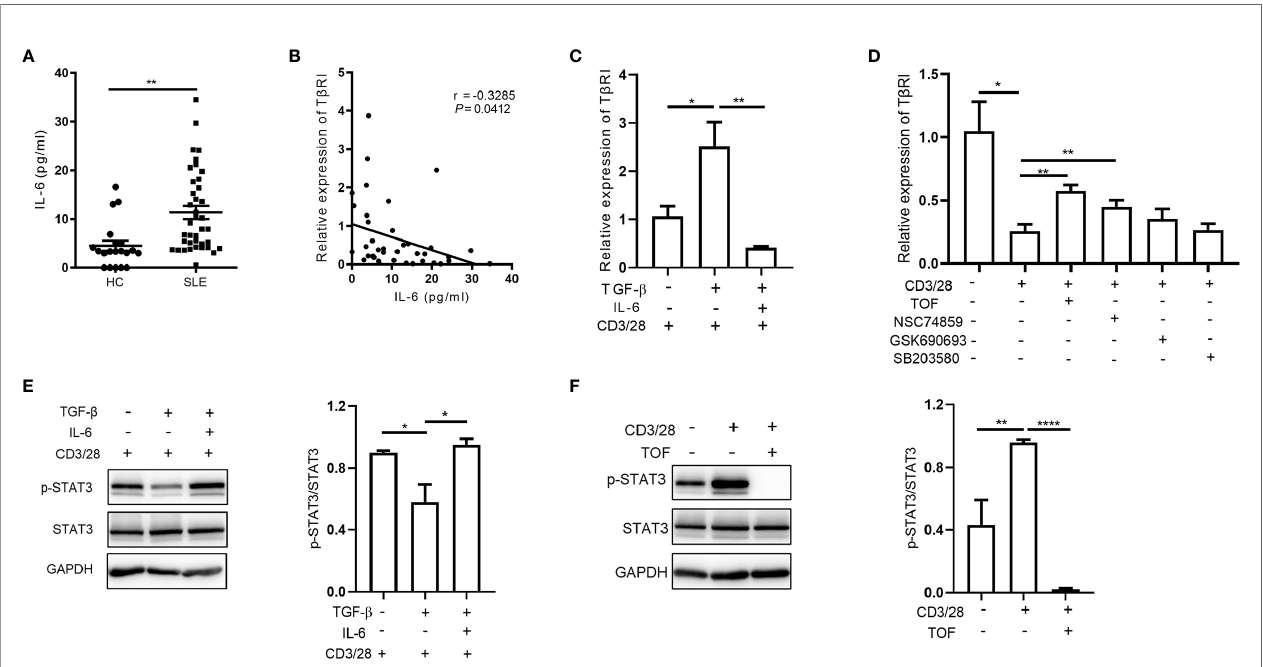
FIGURE 2 | IL-6 downregulates TGF b RI expression via JAK/STAT3 pathway. (A) Plasma IL-6 levels in SLE patients (n = 39) and HC (n = 20) were measured. (B) Correlation between IL-6 and TGF b RI (T b RI) mRNA level was evaluated (n = 39). (C) The TGF b RI mRNA level in naïve CD4 + T cells from SLE PBMCs was assessed after stimulation with anti-CD3/CD28 beads and TGF- b (5 ng/ml) in the absence or presence of IL-6 (100 ng/ml) for 24 h (n = 4). (D) The level of TGF b RI mRNA (n = 3) in anti-CD3/CD28-treated naïve CD4 + T cells from SLE PBMCs was assessed after treatment with JAK inhibitor (tofacitinib, TOF), STAT3 inhibitor (NSC74859), AKT inhibitor (GSK690693), or p38 MAPK inhibitor (SB203580) (10 µM). (E) The phosphorylated STAT3 (p-STAT3) level in CD4 + T cells from HC PBMCs was determined by Western blotting after stimulation with anti-CD3/CD28 beads and TGF- b in the absence or presence of IL-6 for 24 h. p-STAT3 expression was normalized to that of STAT3 (n = 3). (F) The protein levels of p-STAT3 and STAT3 in anti-CD3/CD28-treated CD4 + T cells from HC PBMCs were assessed after treatment with or without TOF (n = 4). Error bars indicate SEM. * P < 0.05, ** P < 0.01, **** P <